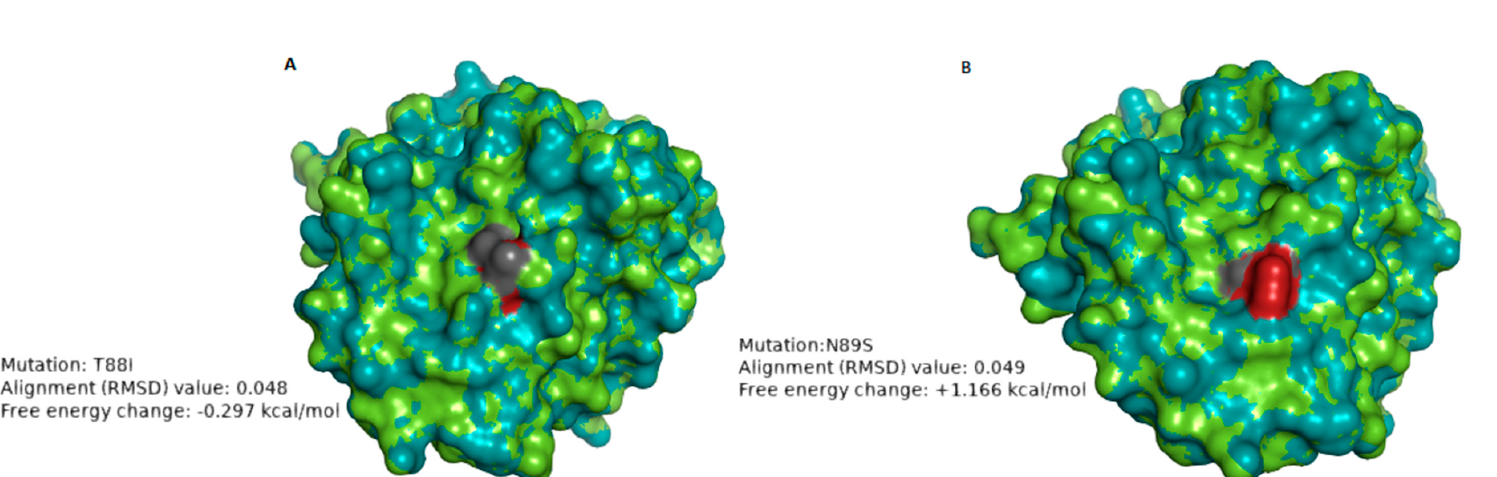
Figure 4. VP4 structure models showing mutations at sites T88I ( A ) and N89S ( B ), respectively, that were only seen in some post-vaccine strains when superposed with VP4 of Rotarix ® . The structure of the study strain is in green while the Rotarix ® structure is in deep-teal. The amino acid residues are represented in dark gray and red to examine whether the replacing amino acid alters the conformation of the protein structure. The amino acid residue highlighted in dark gray represents the study strain while the firebrick red represents the Rotarix ® strain. The stability of the protein after mutation was measured in kcal/mol, whereby the folding energy change of ±0.5 kcal/mol is regarded as statistically significant for either stabilizing (–)/destabilizing (+) effect.